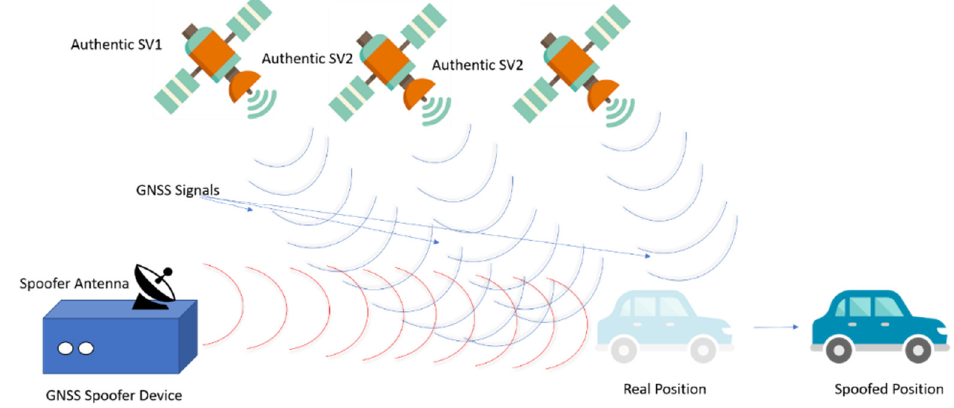
Figure 2. Illustration of a GPS spoofing attack on a vehicle .